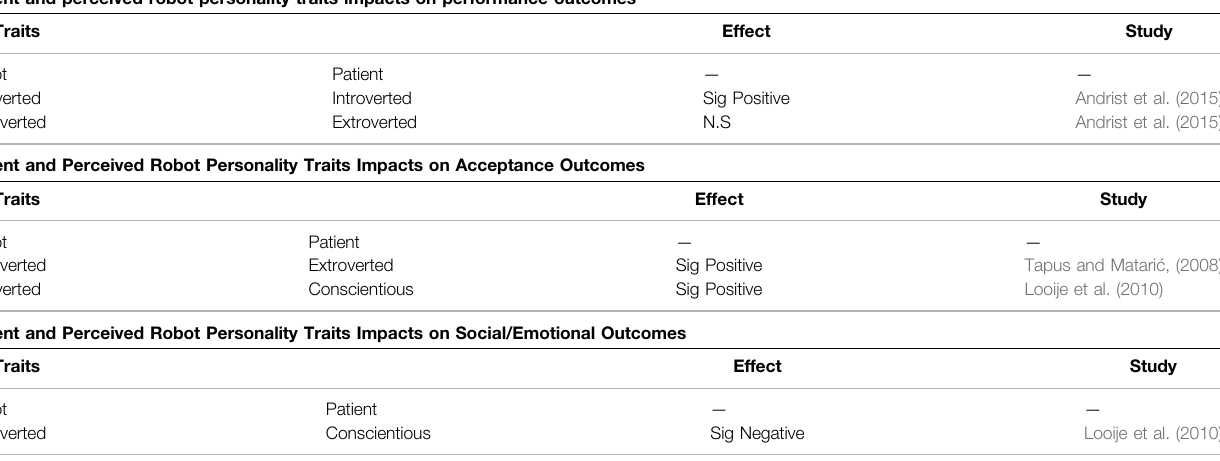
TABLE 8 | Robot and patient personality traits impacts on